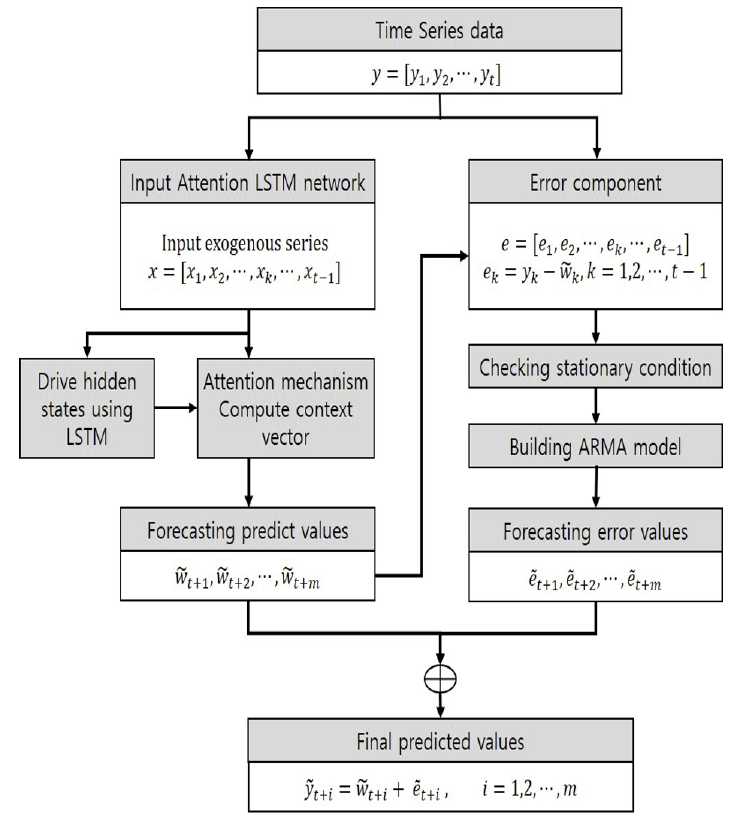
Figure 2. Hybrid forecasting system using attention-based LSTM network and ARMA model.